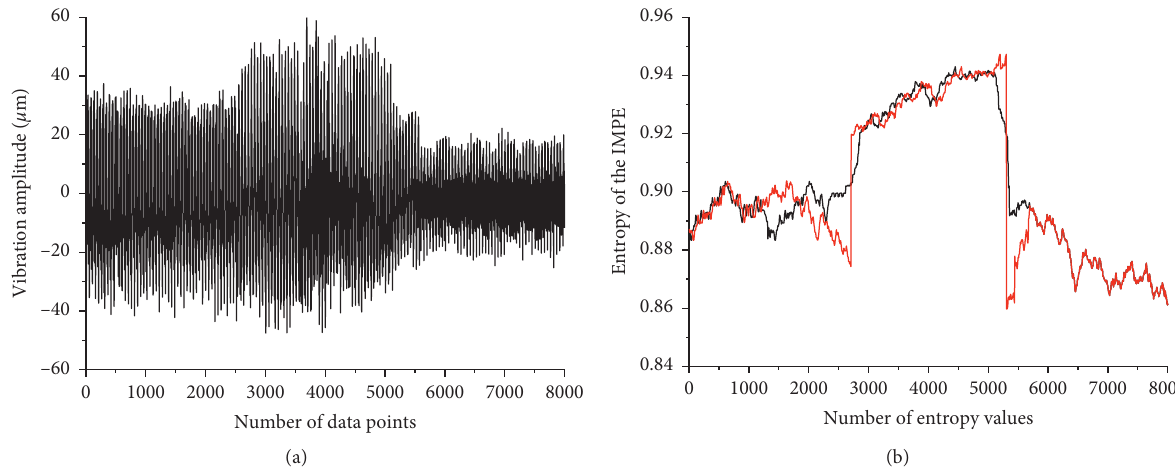
Figure 9: Vibration signal and permutation entropy value change at the pump opening moment. (a) Time course graph of pipeline vibration. (b) Diagram of entropy change under different sequence lengths. Note: the black line is the change of the entropy value of the subsequence N � 1000; the red line is the change of the entropy value of the subsequence N � 2000.